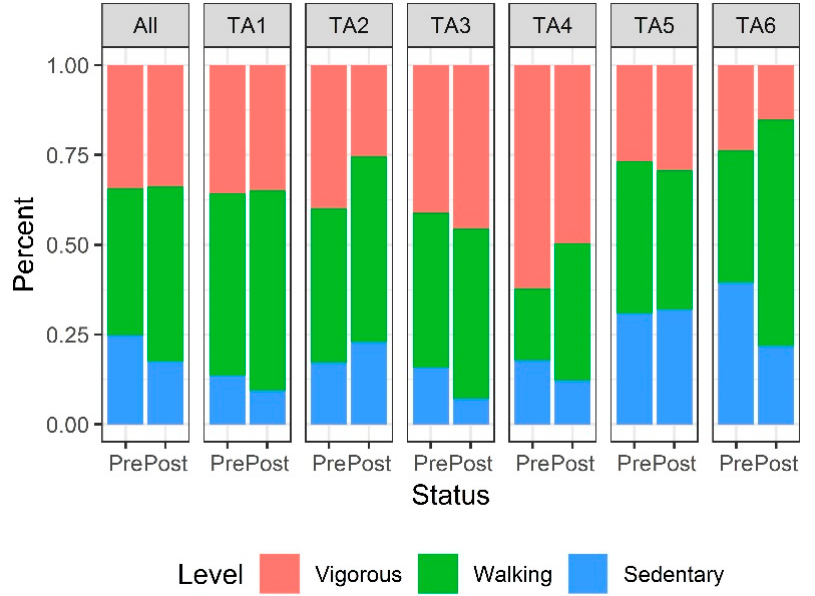
Table 2. Odds of higher physical activity levels post-intervention relative to pre-intervention.